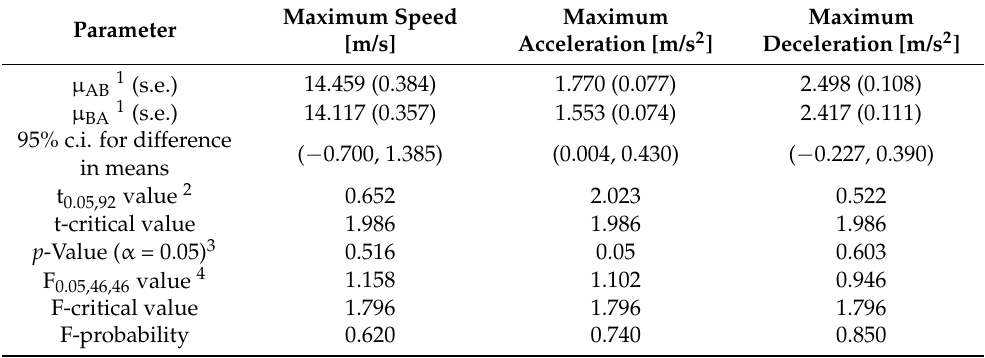
Table 2. Summary statistics for the distributions of key kinematic parameters collected in the field.